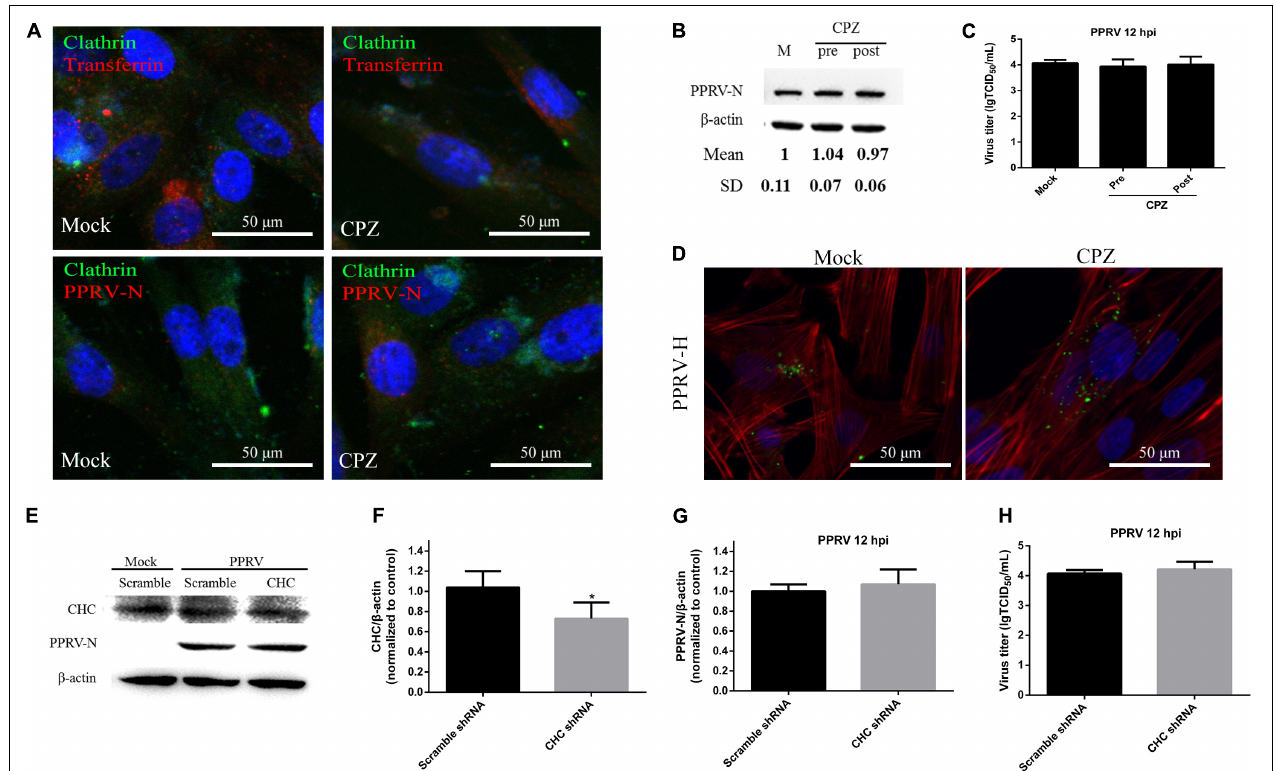
FIGURE 4 | CME is not the pathway for PPRV entry into EECs. (A–C) Effect of CPZ treatment on PPRV entry and infection. (A) CLSM analysis of clathrin (green), viral particles (red) and cell nuclei (blue) in PPRV-infected EECs pre-treated with CPZ. The effect of CPZ on Alexa Fluor 594–TF uptake was used as a positive control (red fluorescence). (B) Western blot analysis of the entry of PPRV into CPZ-treated cells. β -actin was used as an internal control. (C) Virus titration results of PPRV in CPZ -treated cells. (D) CLSM analysis of TRITC-phalloidin (red), anti-PPRV (green) and DAPI (blue) in PPRV-infected EECs pre-treated with CPZ. (E) Western blot analysis of the entry of PPRV into shRNA-transfected cells. (F) Efficiency of CHC downregulation was analyzed by immunoblotting. (G) The relative quantification of viral proteins was determined by densitometry against β -actin in shRNA-transfected cells. (H) Virus titration analysis of PPRV in shRNA-transfected cells. The bars indicate the mean ± SD from three independent experiments. SD, standard deviation; ∗ P < 0.05; ∗∗ P <